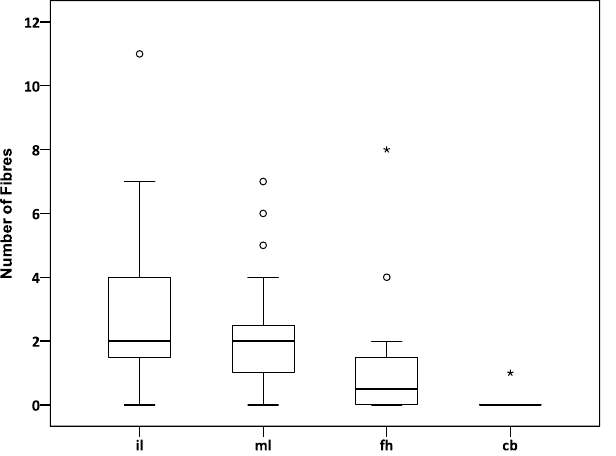
Figure 1. Number of aerial microfibres monitored in the samples. The boxplots show the number of airborne fibres detected in the samples belonging to the four different setups (il = indoor laboratory; ml = mobile laboratory; fh = laboratory fume hood; cb = clean bench with particle filtration). The boxes cover the 25th and 75th percentile, including the median (horizontal line). The whiskers are set to default representing ± 1.5 * IQR (interquartile range).